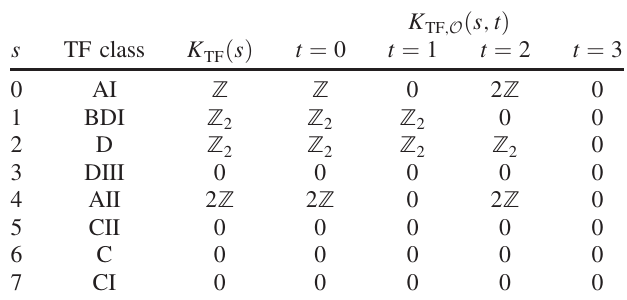
TABLE XXVII. The groups K 0 ; 0 ; 0 Þ for the real Shiozaki-Sato classes with a unitary order- two (anti)symmetry.